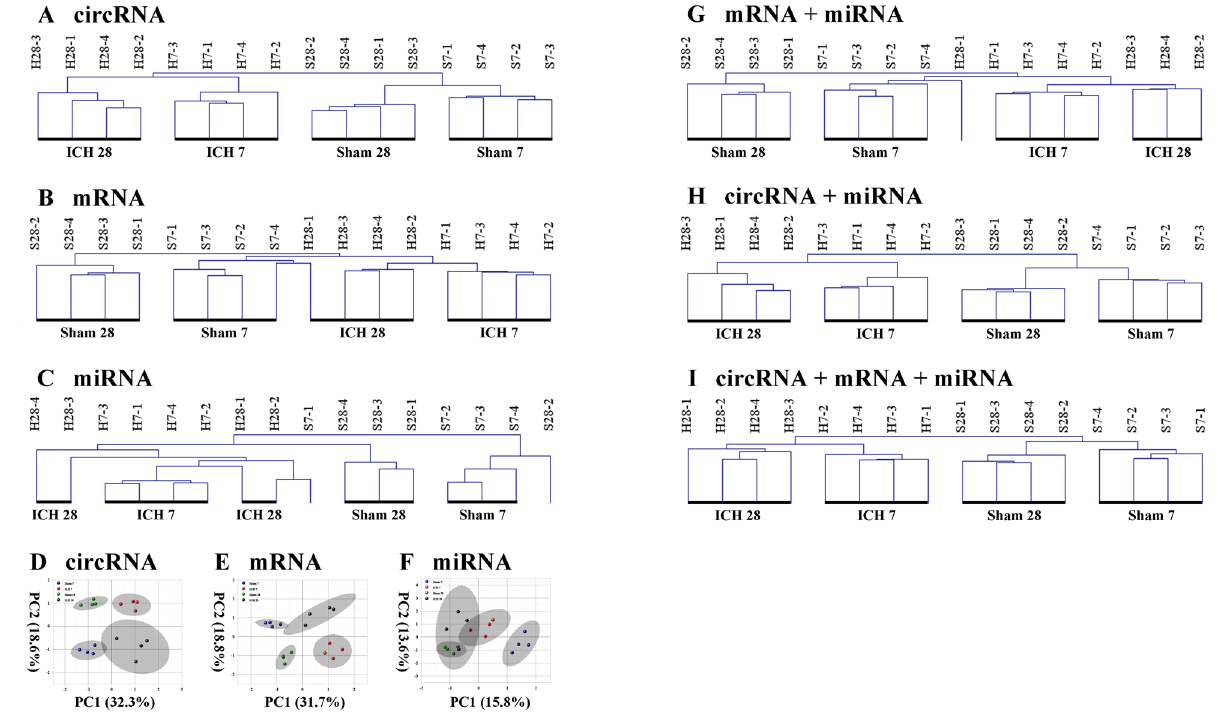
Figure 5. Expression signatures of circRNA, mRNA and miRNA expression profiles. ( A ) Unsupervised hierarchical clustering analysis of circRNA revealed that circRNA provided discriminatory power to precisely classify day-7 and day-28 samples. ( B ) Unsupervised hierarchical clustering analysis of mRNA revealed that mRNA provided discriminatory power to precisely classify day-7 and day-28 samples. ( C ) Unsupervised hierarchical clustering analysis of miRNA revealed that miRNA did not provide discriminatory power to precisely classify day-7 and day-28 samples. Principal component analyses of circRNA ( D ), mRNA ( E ) and miRNA ( F ) expression profiles showed similar findings. The variances explained by the principal components chosen were shown as PC1 and PC2. ( G ) Unsupervised hierarchical clustering analysis of